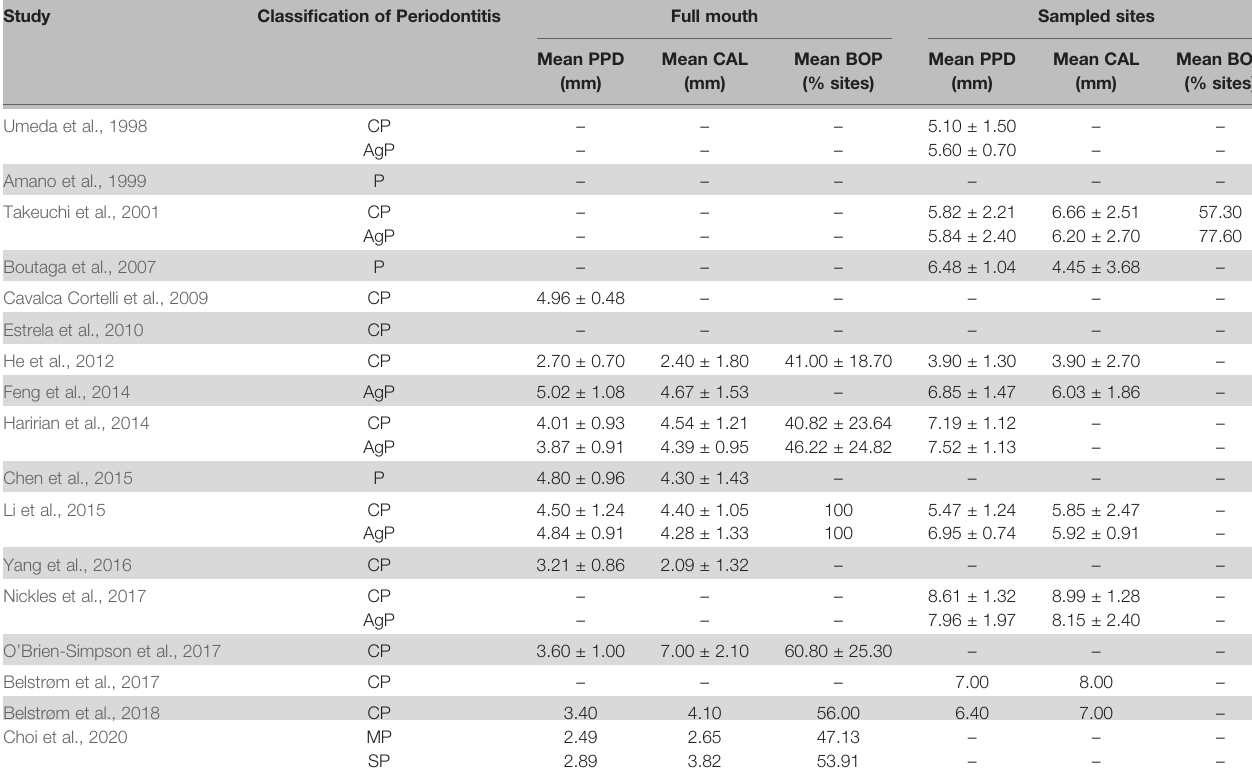
TABLE 2 | Clinical parameters (PPD, CAL and BOP) of periodontitis patients in the included